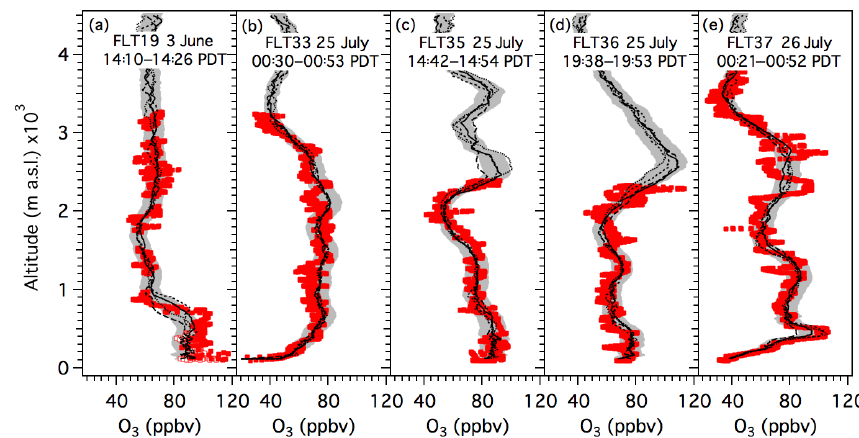
Figure 9. Profile plots comparing the TOPAZ (black lines) and Scientific Aviation (red squares) O 3 measurements on (a) FLT19, 3 June; (b) FLT33, 25 July; (c) FLT35 25 July; (d) FLT36, 25 July; and (e) FLT37, 26 July. The dotted, short-dashed, solid, and long-dashed lines show the four consecutive 8min lidar profiles acquired during the aircraft profiles. The gray envelopes show the mean lidar profile ± 10% as reference. Note the large variability near the surface and the sharp transition at 800m in the 3 June aircraft measurements (see Fig. 3a).